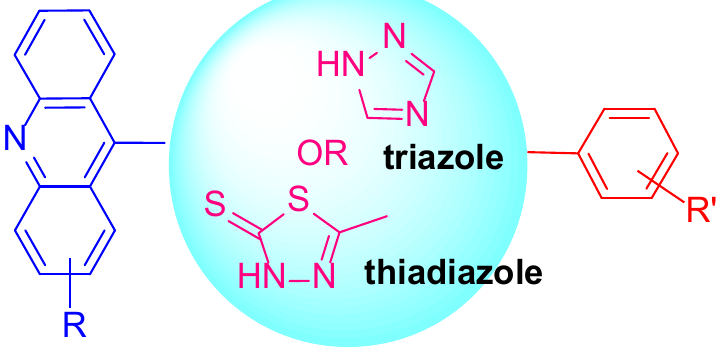
Figure 2. Strategy for the design of acridine-triazole or acridine-thiadiazole hybrids.